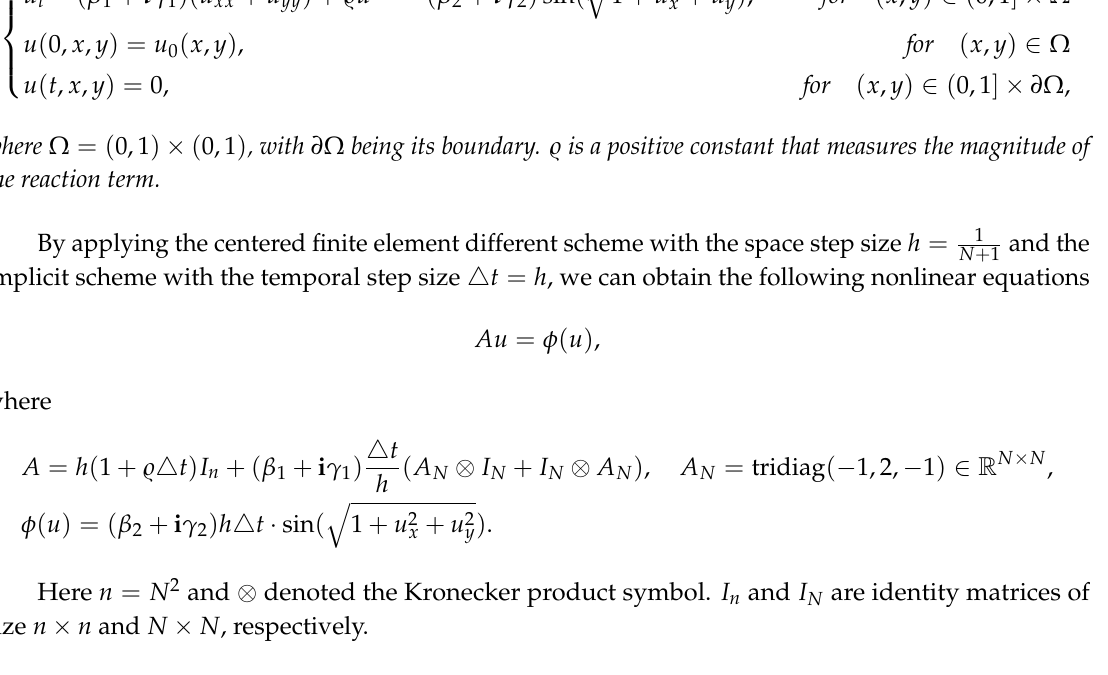
Table 2. Cases with respect different choices of